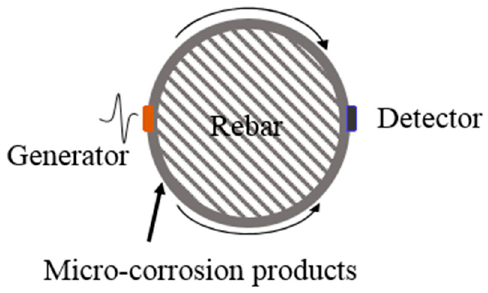
Figure 1. The principle of ultrasound corrosion monitoring.